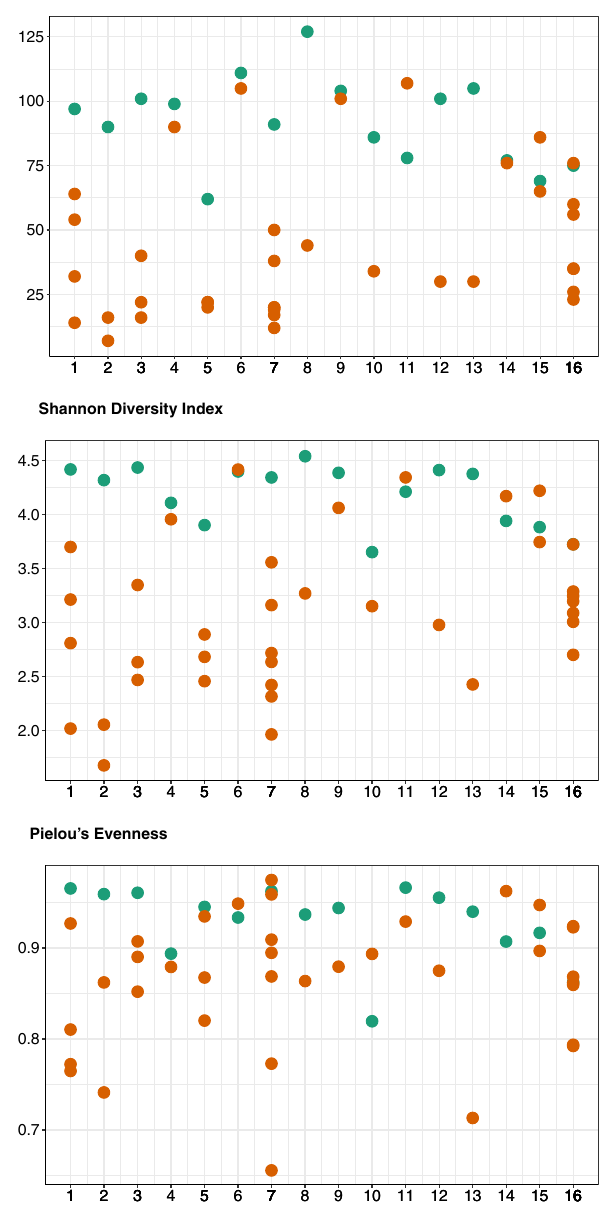
Figure 8. The alpha diversity measures of ARG richness, evenness, and Shannon diversity did not significantly differ by family. However, differing levels of variance were observed among families, particularly when comparing families with one control sample vs. many. Each column in the dotplot represents a single family with one case sample (green circle) and one or more control samples (orange circles). P-values were calculated using the Wilcoxon rank-sum test but none were